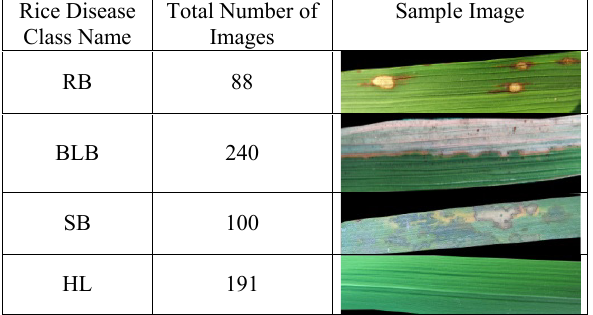
Table 1. Details of Four Rice Diseases in the Dataset with Sample Images from Each Class